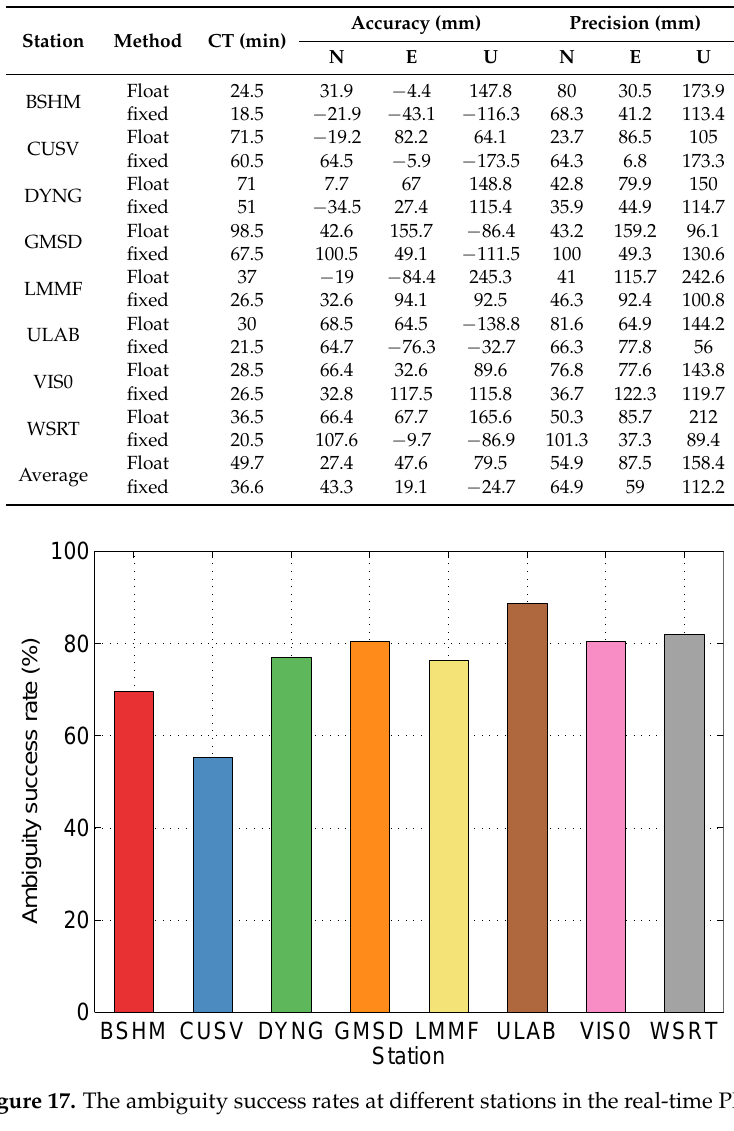
Figure 16. Positioning error of fixed solution at different stations in the real-time PPP. Table 4. Positioning performance at different stations in the real-time PPP.